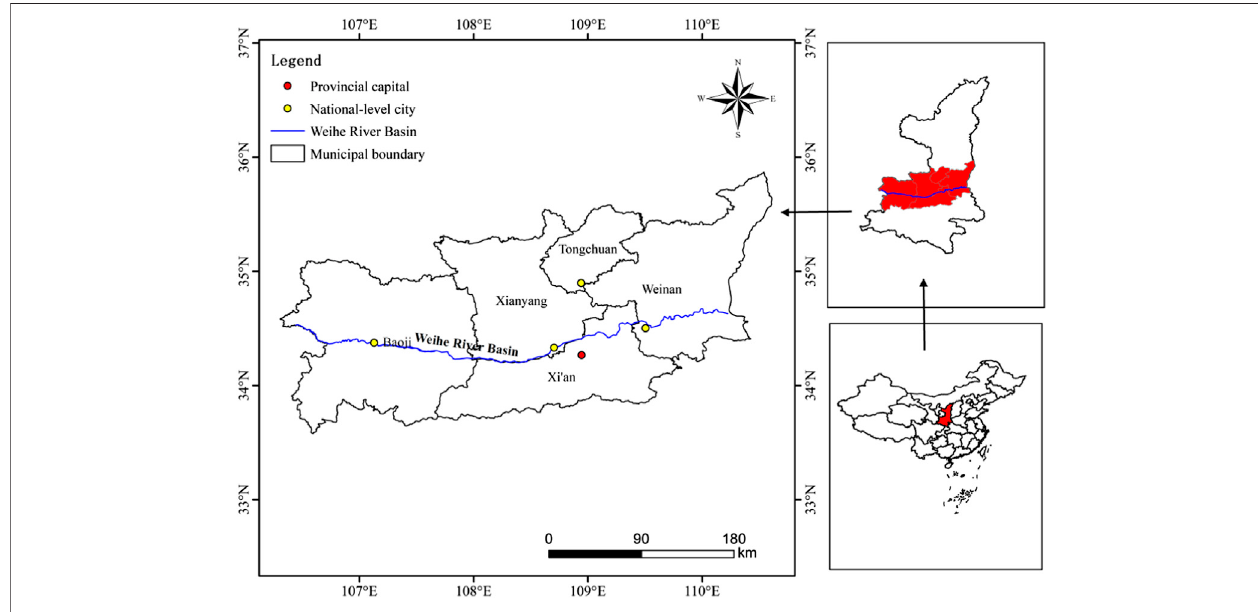
FIGURE 1 | The location of study area in